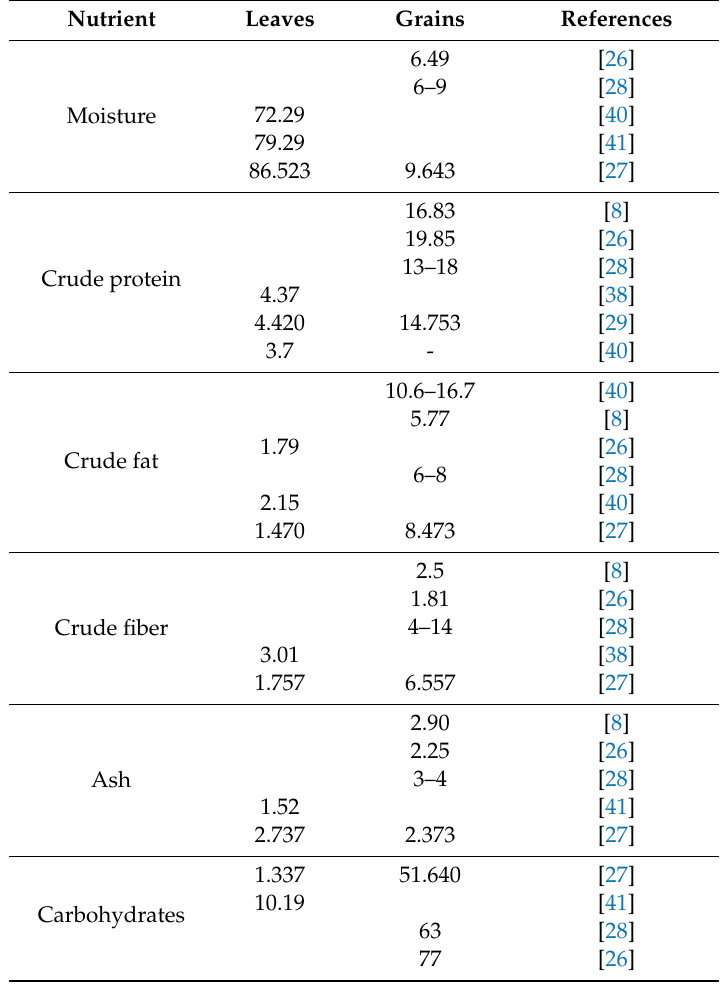
Table 2. Comparative proximate analysis (%) of Amaranthus leaves and